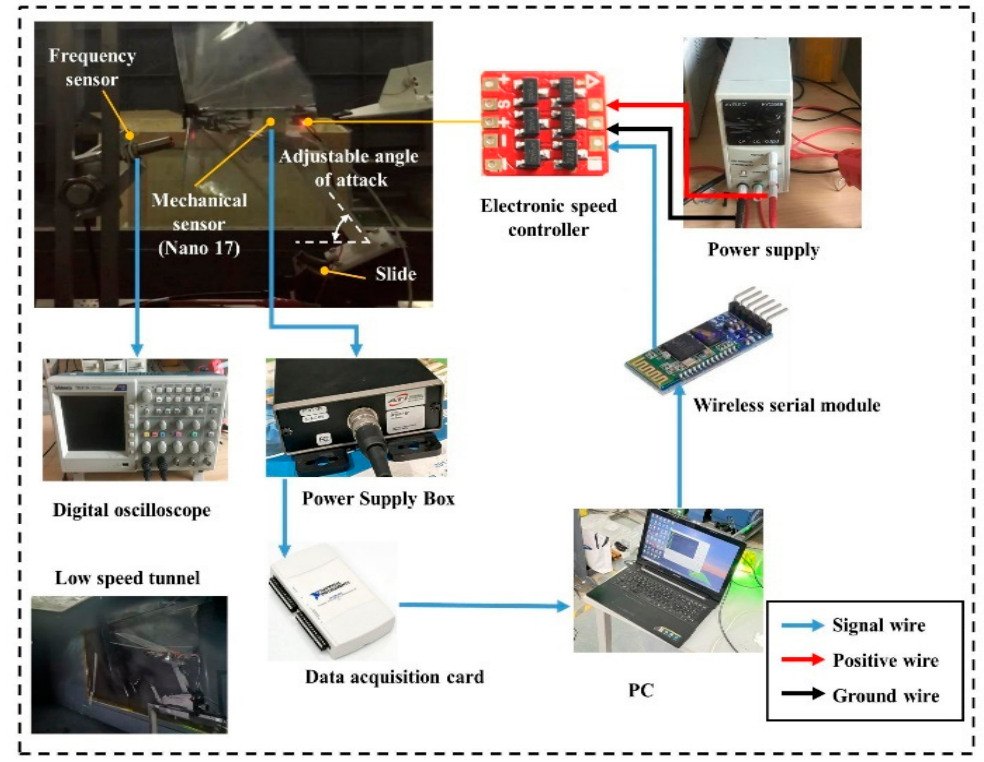
Figure 6. Experimental platform for force and moment measurement of CWMAV.